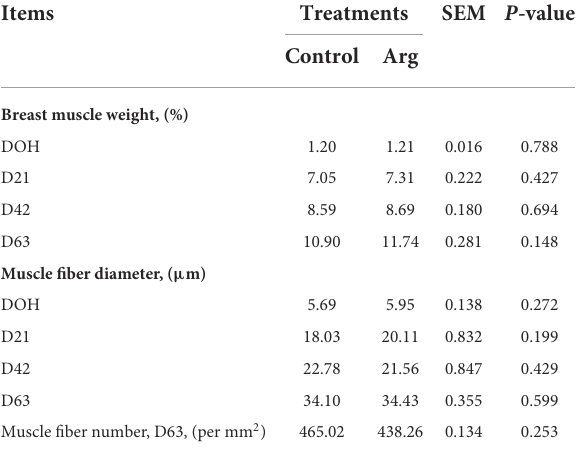
TABLE 3 In ovo feeding of L-arginine on breast muscle weight and muscle morphology in slow-growing chickens.